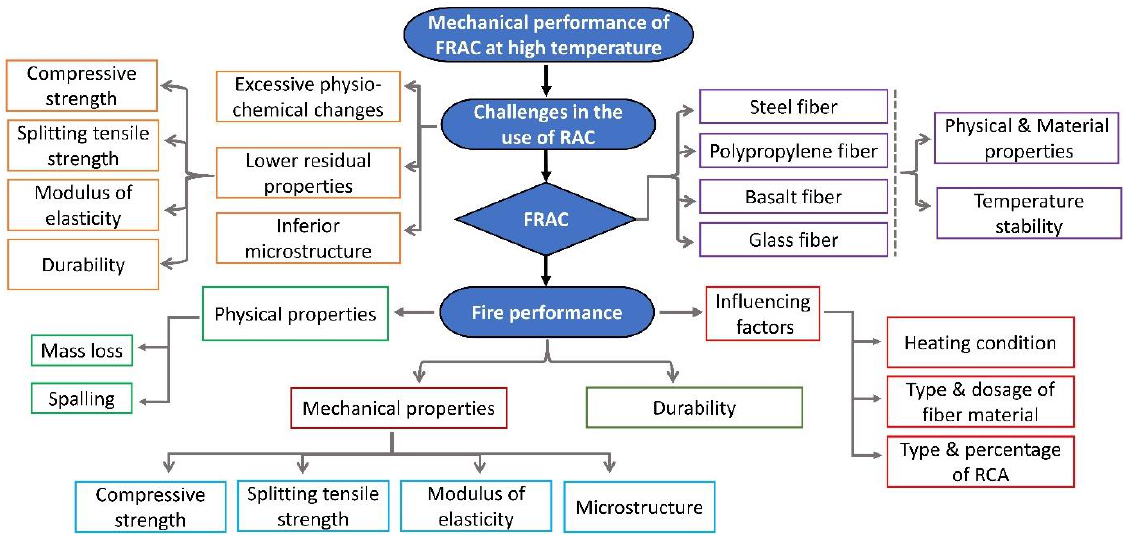
Figure 1. Systematic flowchart showing details of various key parameters of residual properties of FRAC that are covered in this review study [19,28,32,49 – 52].